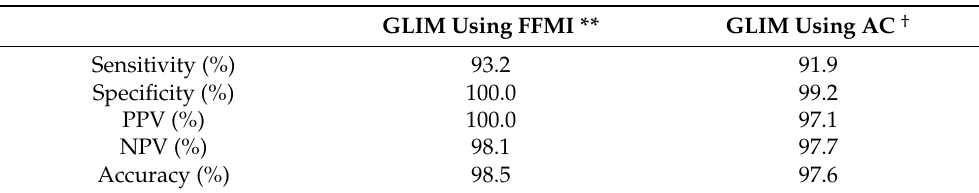
Table 3. Statistical evaluations of GLIM malnutrition using FFMI or AC for GLIM malnutrition using the SMI * in the validation group.